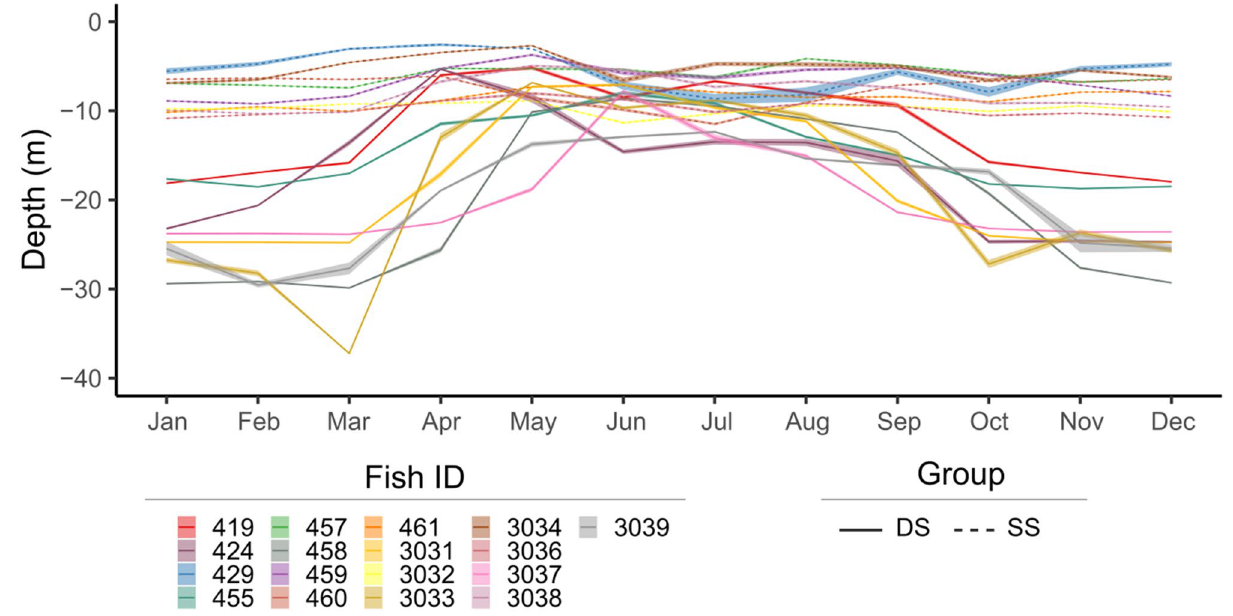
Figure 4. Monthly individual depth. Mean (± SE) depth of each fish identified by their identification number (Fish ID) and by group ( SS shallow/shallow, DS deep/shallow), over the study period (all years included).